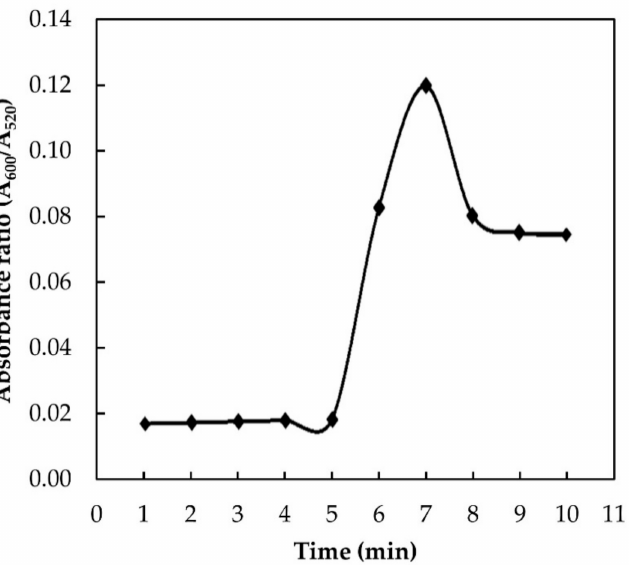
Figure 5. Effect of interaction time on absorbance ratio (A 600 /A 520 ) of AuNPs in the presence of 9.6 × 10 − 3 M